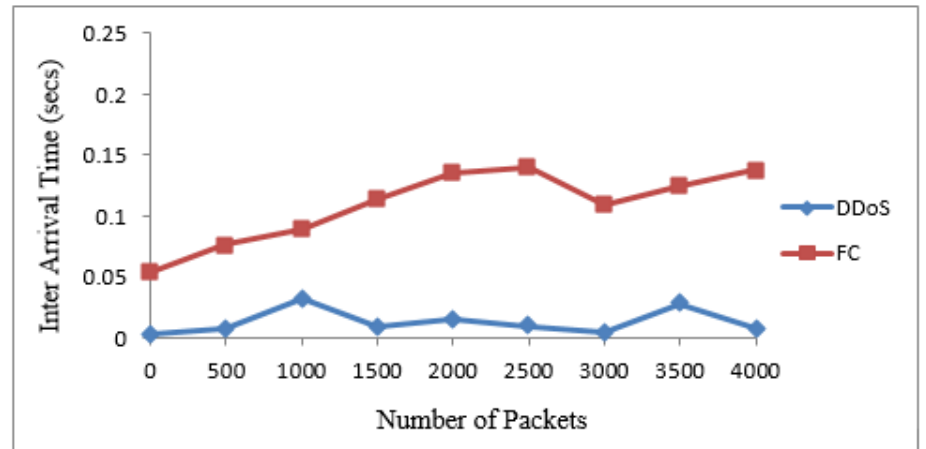
Figure 9. Discrimination of DDoS attack from FC based on IAT.